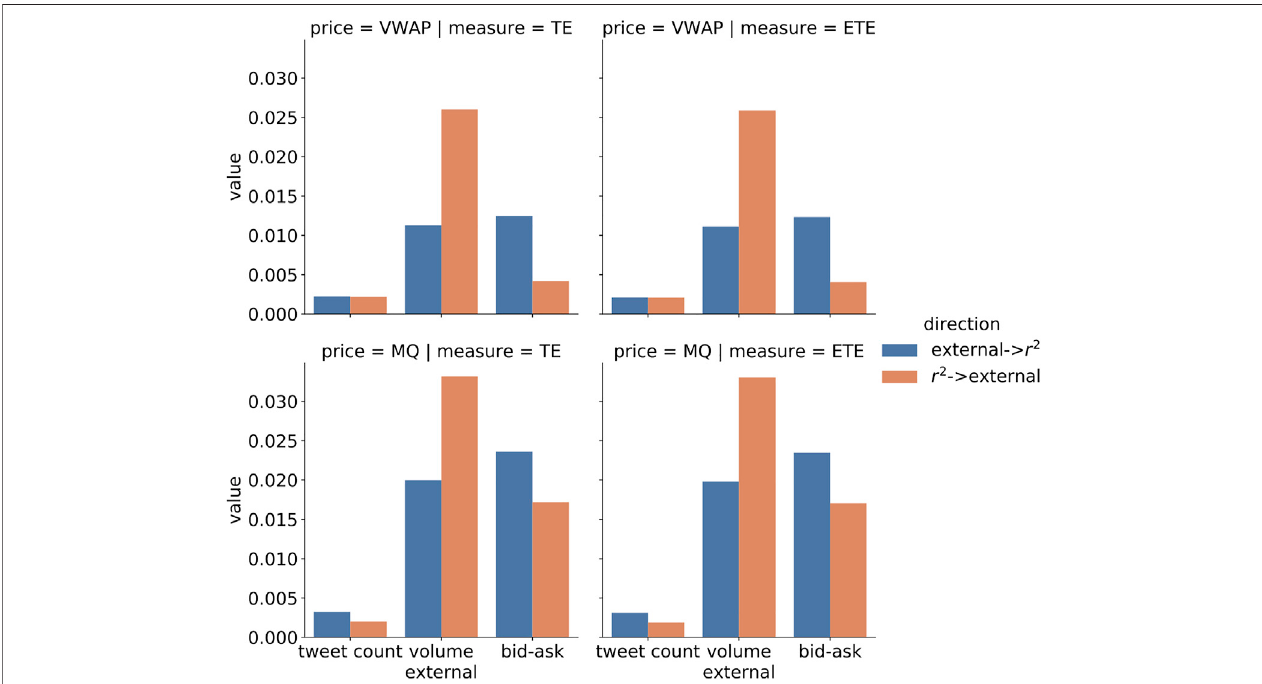
FIGURE 4 | Transfer entropy (TE) and effective transfer entropy (ETE) between external signals (Twitter, volume, and bid – ask spread) and squared returns (VWAP and mid-quoteprice returns). Alltransfer entropyresults are statistically signi fi cant( p -value smaller than 0.001),additionally thepresence ofunit-roots waschecked with augmented Dickey – Fuller test ( α (cid:1) 0 . 01).